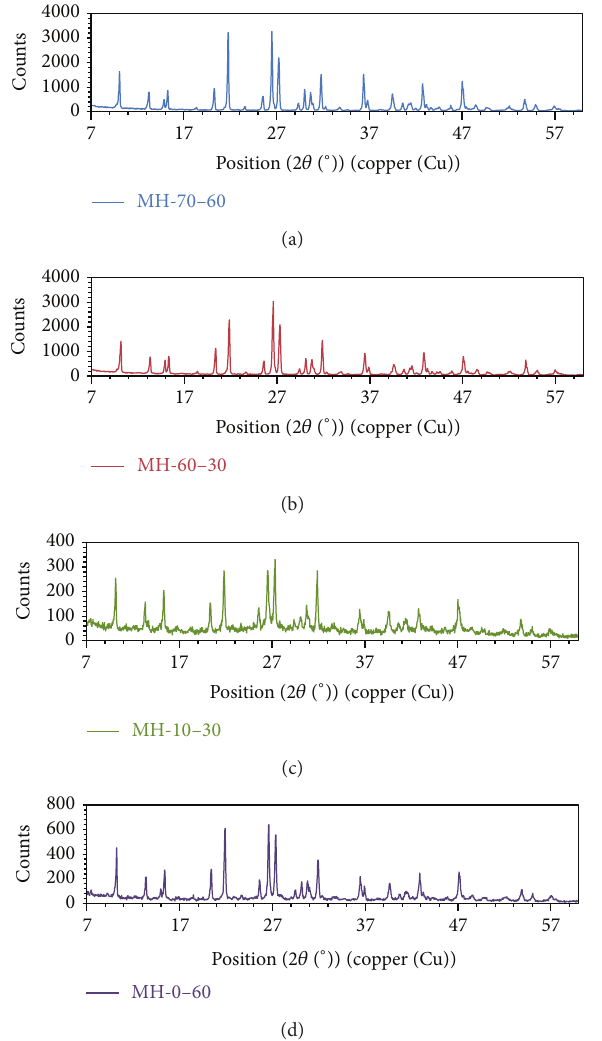
Figure 3: XRD patterns of synthesized pure mcallisterite minerals.